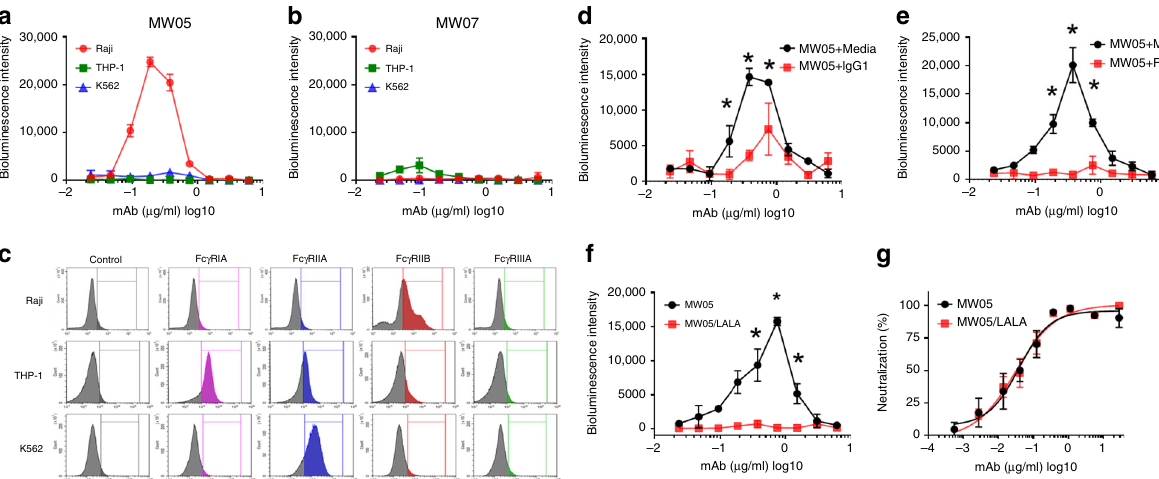
Fig. 3 Crosslinking of Fc and Fc γ R contributing to ADE activities of MW05. a , b ADE activities of MW05 and MW07 were assessed using SARS-CoV-2 pseudovirus. Pseudoviruses pre-incubated with serially diluted mAb mixtures were added to Raji, THP-1, and K562 cells to evaluate their ability to enhance infection. RPMI 1640 media containing 10% FBS was used as a negative control. c The expression level of Fc γ Rs on Raji, THP-1, and K562 cells were checked by FACS. All cells except debris were gated and analyzed based on FSC-A/SSC-A plot. d ADE activities of MW05 on Raji cells pre-treated with media or 400 µ g/ml irrelevant hIgG1 were assessed using SARS-CoV-2 pseudovirus. Statistical signi fi cance was calculated via unpaired two-tailed t- test. * P < 0.05. e ADE activities of MW05 pre-incubated with media or 80 µ g/ml Fc γ RIA were assessed on Raji cells using SARS-CoV-2 pseudovirus. Statistical signi fi cance was calculated via unpaired two-tailed t -test. * P < 0.05. f The ADE activities of MW05 and MW05/LALA on Raji cells were compared using SARS-CoV-2 pseudovirus. Statistical signi fi cance was calculated via unpaired two-tailed t- test. * P < 0.05. g The pseudovirus neutralizing activities of MW05 and MW05/LALA on Huh7 cells were measured. The average ± SD from two independent experiments with technical duplicates is that Fc γ RIIB is the major Fc γ R contributing to the enhancement of SARS-CoV-2 infection mediated by MW05.